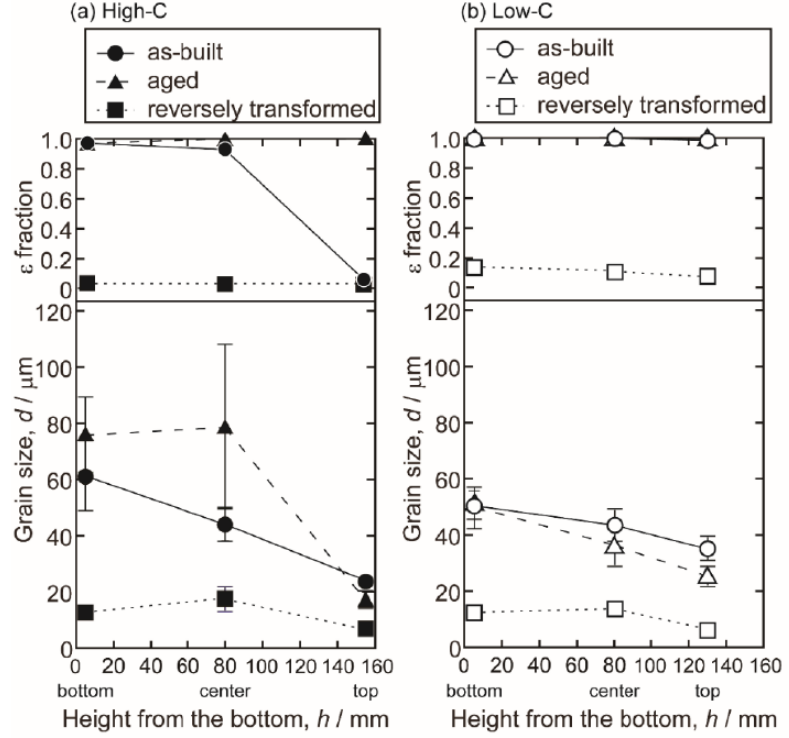
Figure 3. ε -phase fraction and average grain size at the top, center, and bottom parts of the as-built, aged, and reversely transformed specimens of ( a ) high-C and ( b ) low-C alloys.